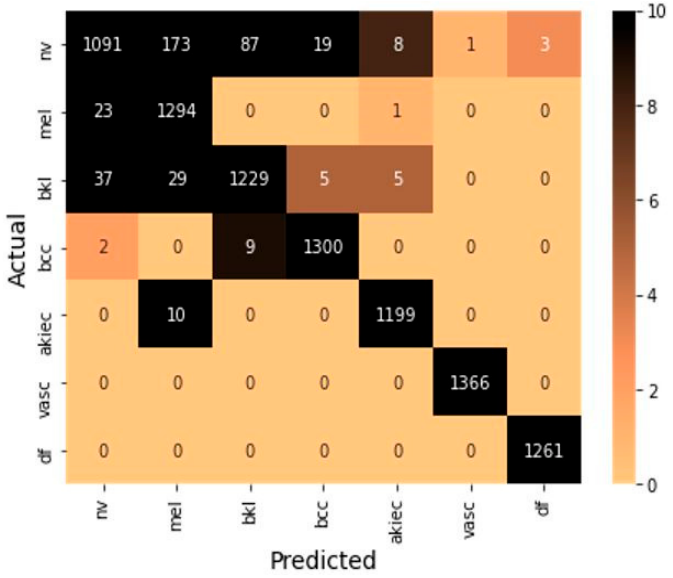
Figure 5. Confusion matrix on testing samples.